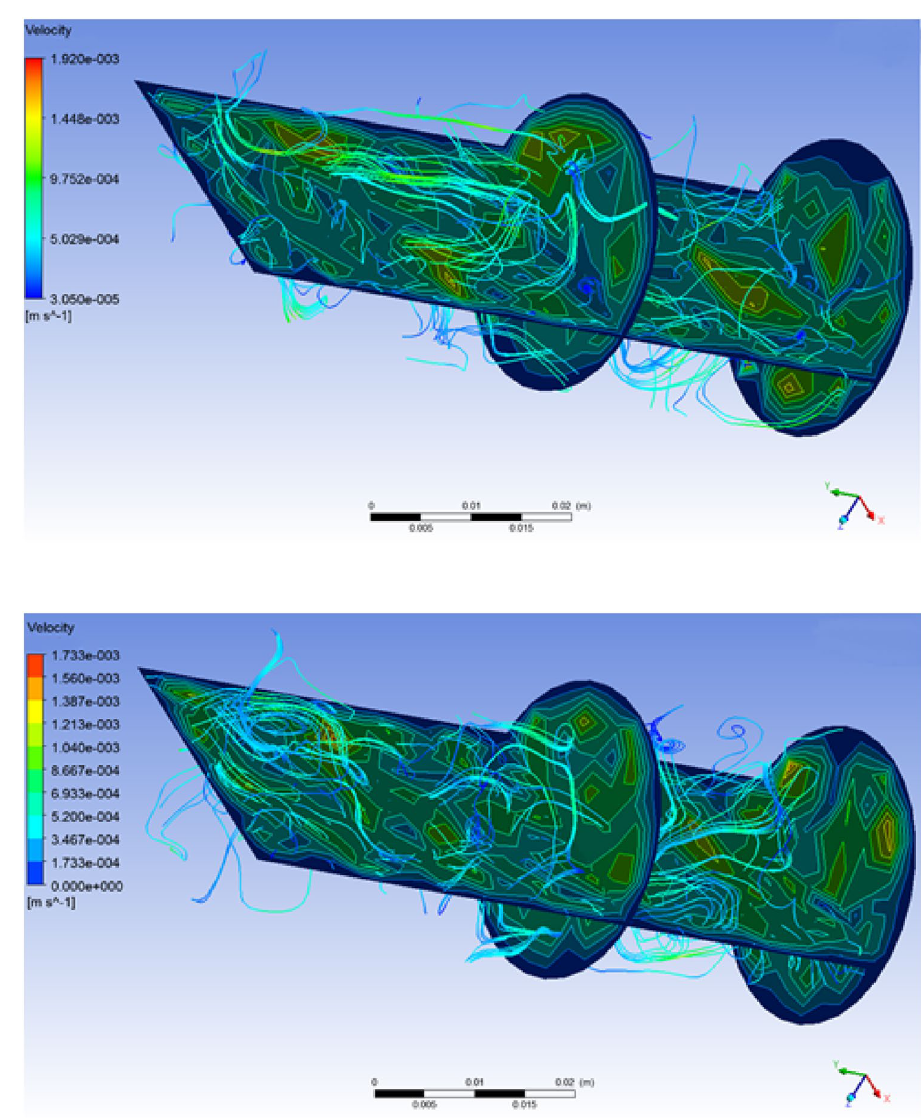
Fig. 11 Profile of flow veloci- ties across pore throats before asphaltene deposition